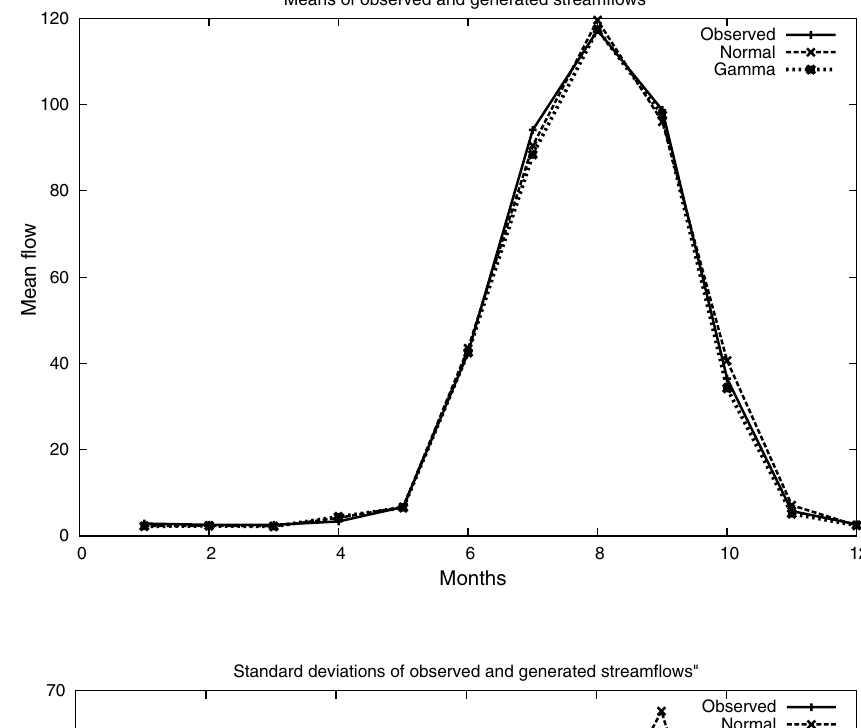
Standard deviations of observed and generated